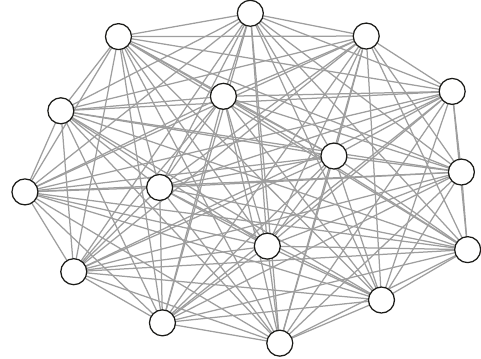
Figure 2: Erdös-Rényi network of size 16